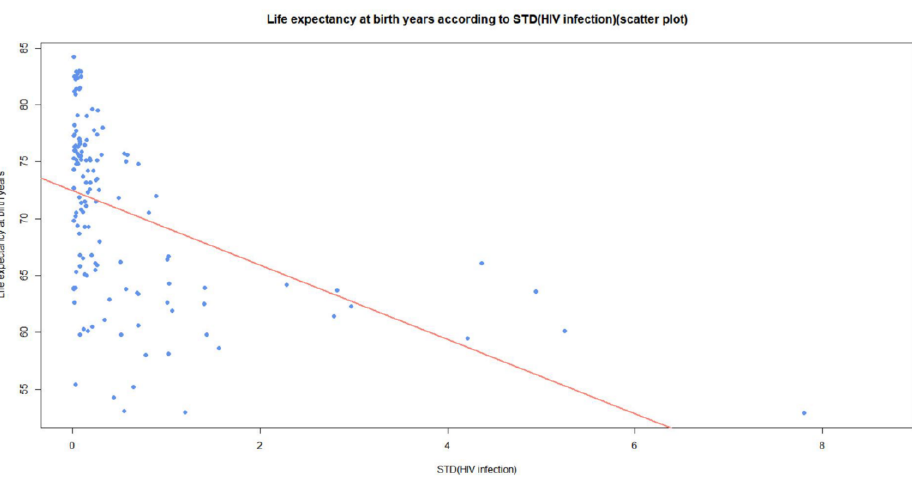
Table 15. Regression between STDs (HIV infection) and density of medical doctors. - Estimate